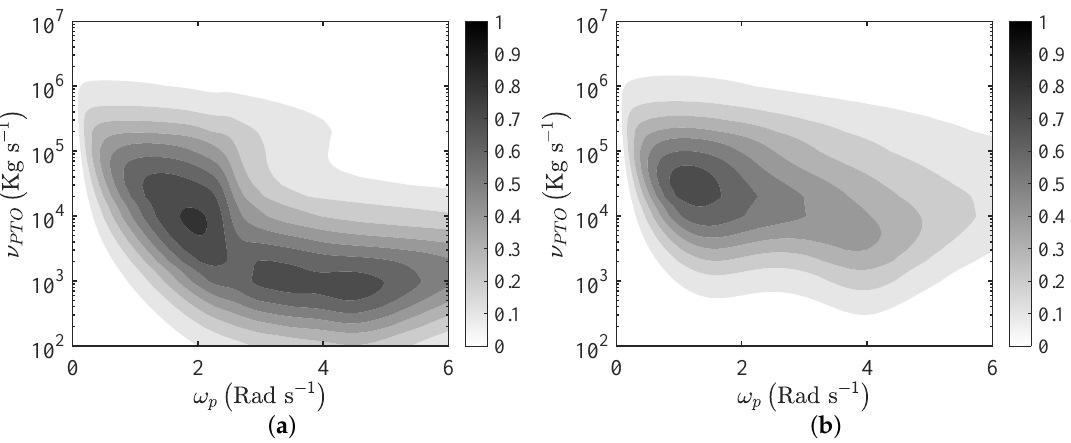
Figure 12. Behaviour of the Capture Factor in irregular sea waves versus peak frequency of the incident JONSWAP spectrum and PTO-Coefficient. ( a ) Softened flexible plate with stiffness factor EI = 6.9 × 10 3 kg m 3 s − 2 ; ( b ) The case of a rigid